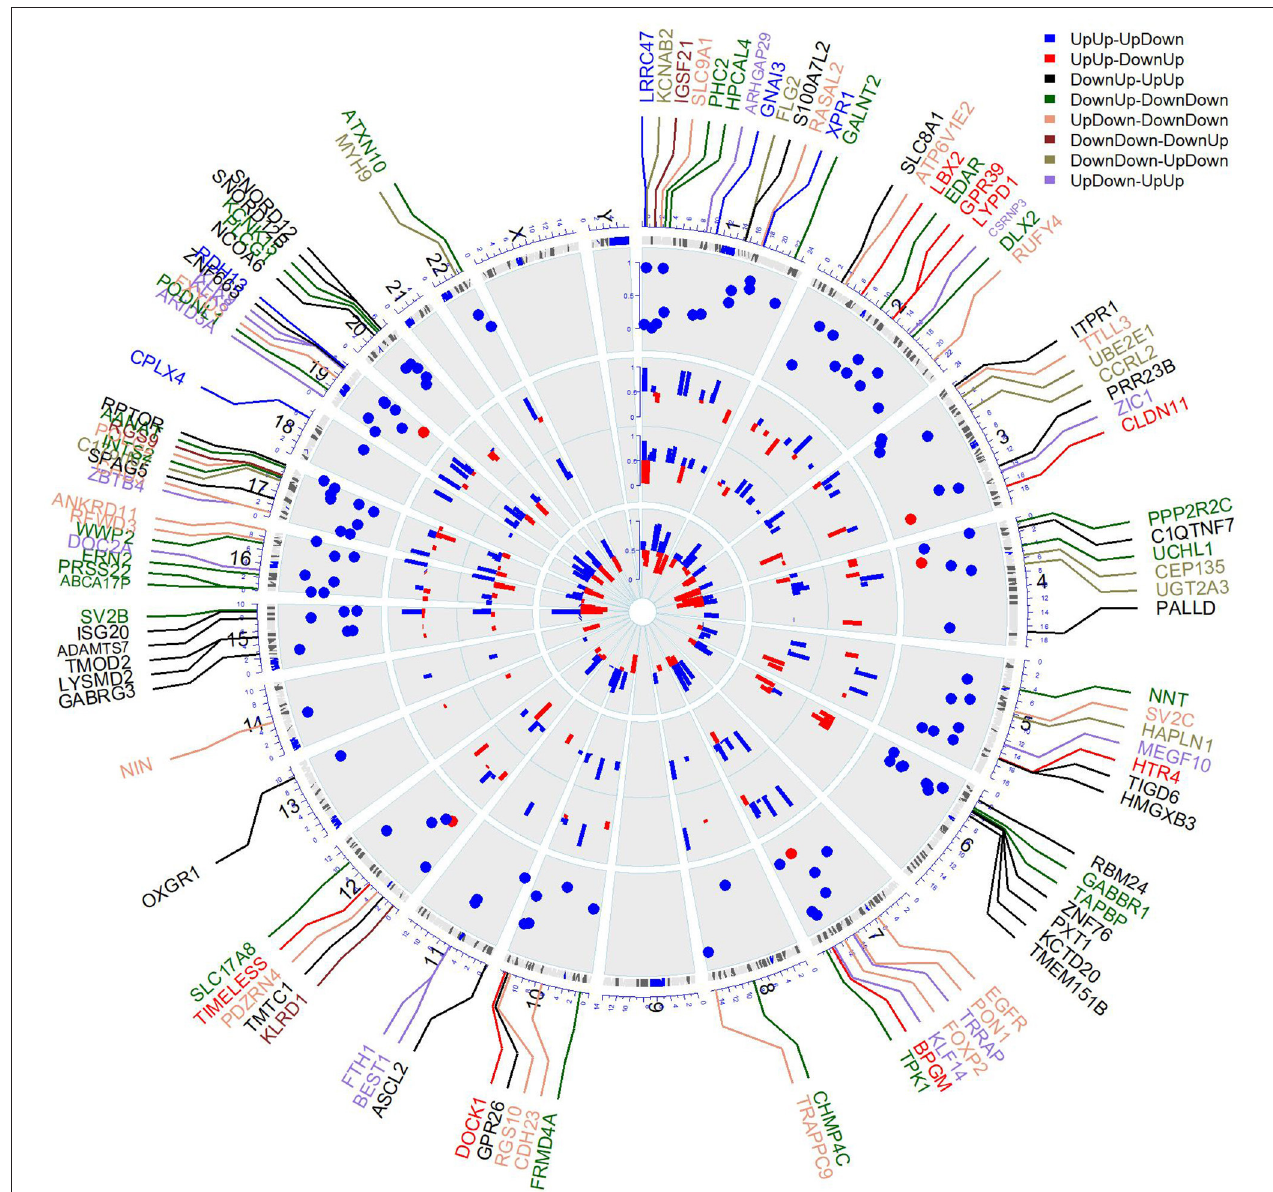
FIGURE 3 | Circular plot of DNA methylation levels of significant genes in stromal myofibroblasts. The outermost ring represents human ideograms, i.e., genome positions by chromosomes. The black lines are cytobands. The labels outside the ring are the names of significant genes (probes) selected by BACkPAy. Different colors of these gene labels represent the differential methylation patterns significant genes belong to among ATM (adjacent tissue-derived myofibroblast), CAM (cancer-associated myofibroblast), and NTM (normal tissue-derived myofibroblast) groups comparing male to female samples; each tissue type contains three samples, Bayesian q -value 0.05. The first track shows the adjusted p-value of these prognostics genes with the survival data in TCGA package. (red: FDR p -value < ≤ 0.05, blue: FDR p -value > 0.05). The second track, the third track and innermost track represent the DNA average methylation levels of corresponding CpG sites from significant genes among CAM, ATM, and NTM, respectively. (red: β value < 0.2, hypermethylated loci, blue: β value > 0.2). The complete list of genes (with colors) is available in the Supplementary Material (section